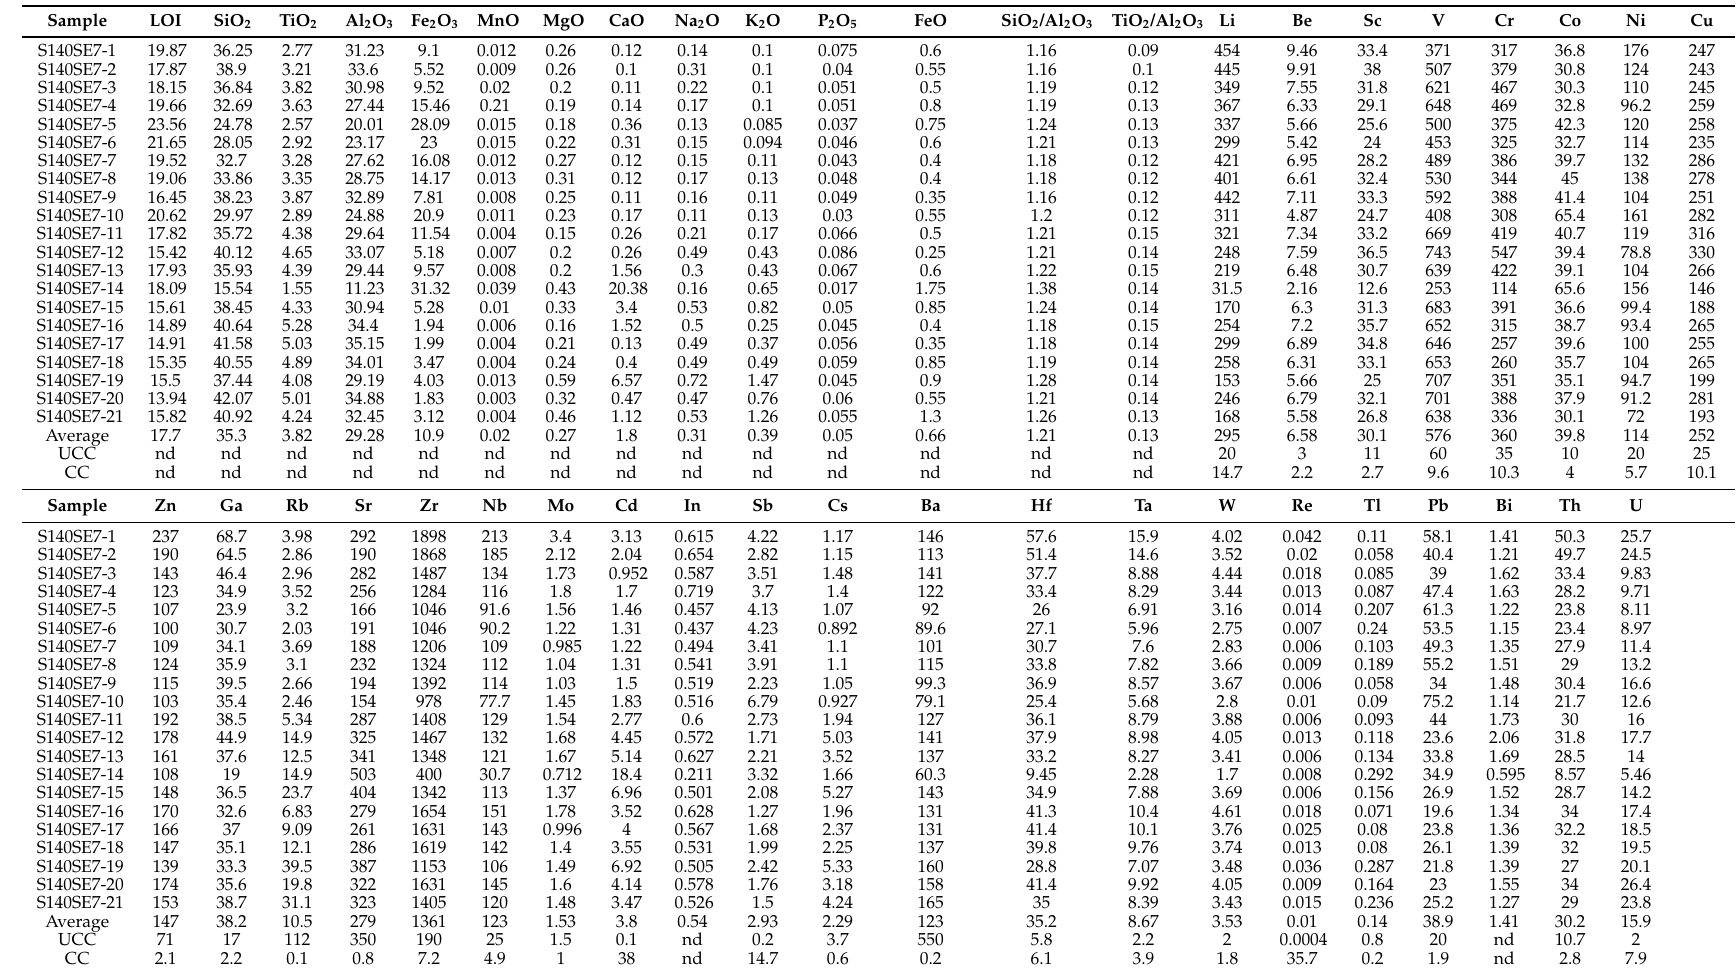
Table 2. Elemental concentrations in Tuff samples from the Zhongliangshan Mine (elements in µ g/g, Oxides in %).